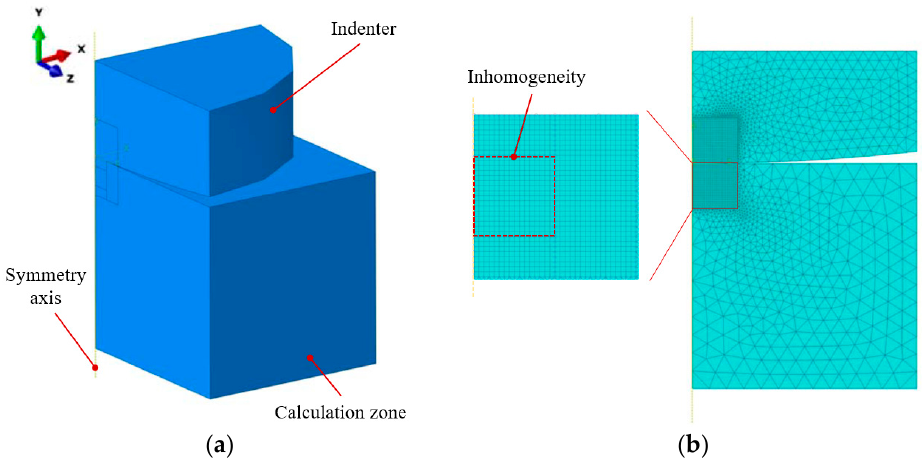
Figure 12. Schematic of ( a ) finite element model and ( b ) mesh local refinement.